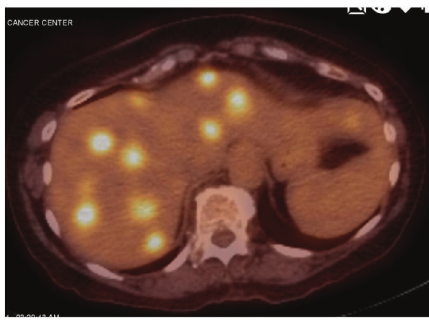
Figure 1: Preoperative PET.